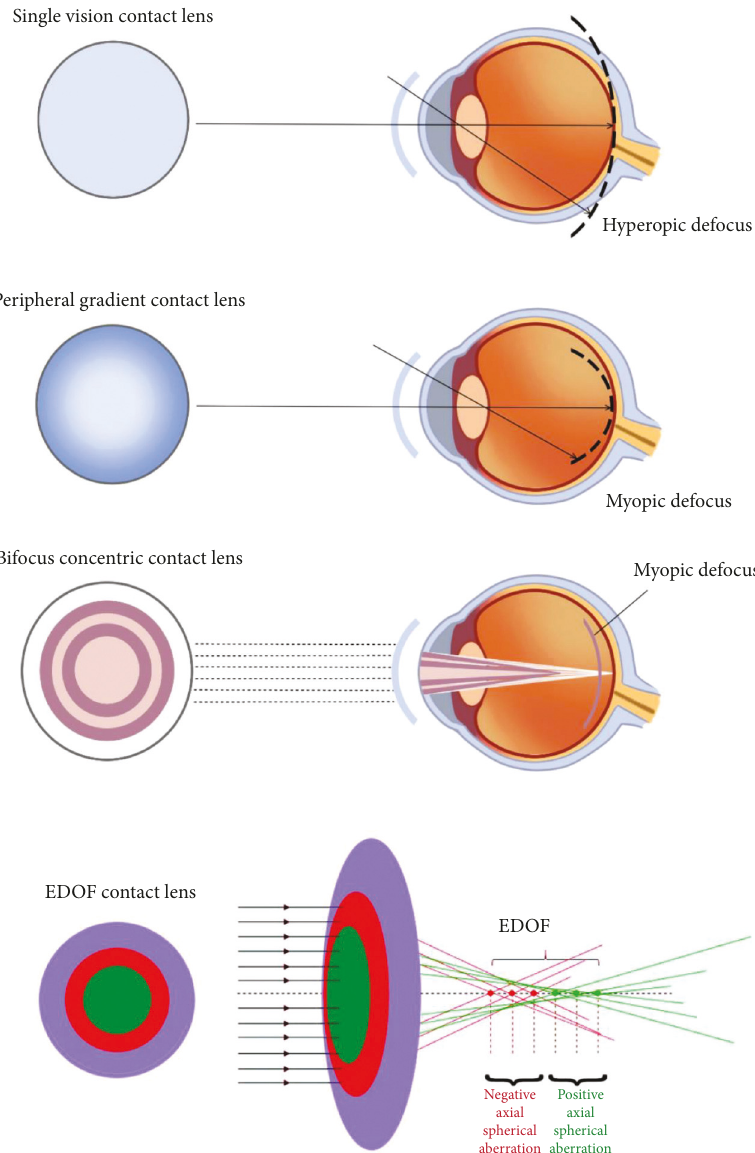
Figure 3: Single-vision contact lenses (CLs) provide a peripheral hyperopic defocus. A peripheral myopic defocus can be achieved with peripheral gradient CL, bifocal CL, and EDOF